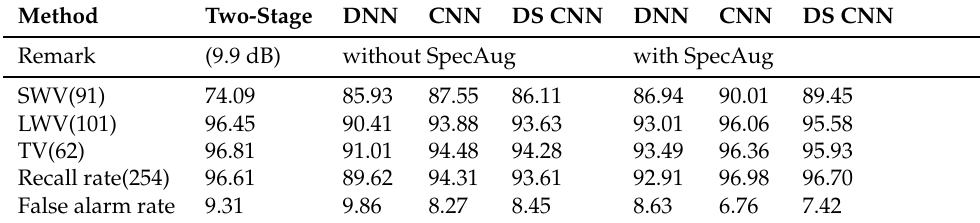
Table 5. The ability to detect different types of vehicle of the models.